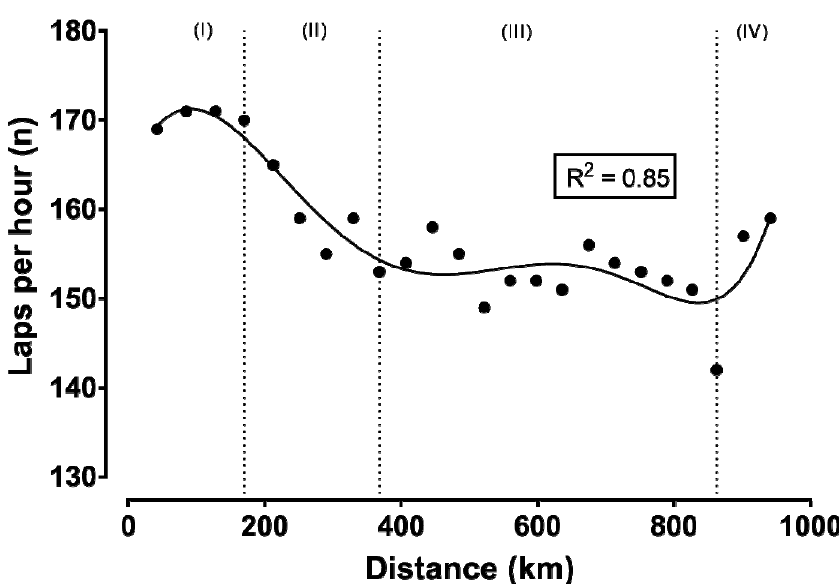
Figure 3. Number of laps per hour during the record attempt. Latin numbers (I, II, III, IV) denote the phases of the race, which are separated by vertical dashed lines. The previous attempt (road cycling) is not presented due to different lap distance. R 2 estimates the goodness of fit.